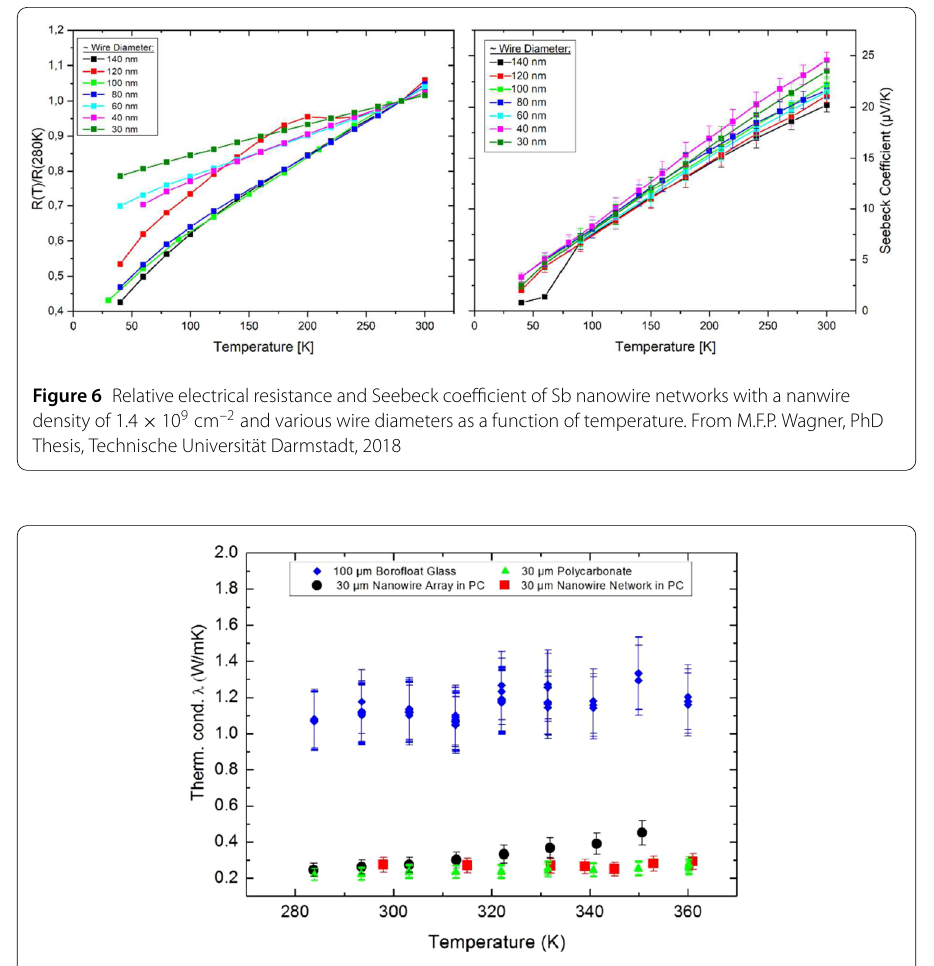
Figure 7 Thermal conductivity of various samples as a function of temperature. From M.F.P. Wagner, PhD Thesis, Technische Universität Darmstadt,